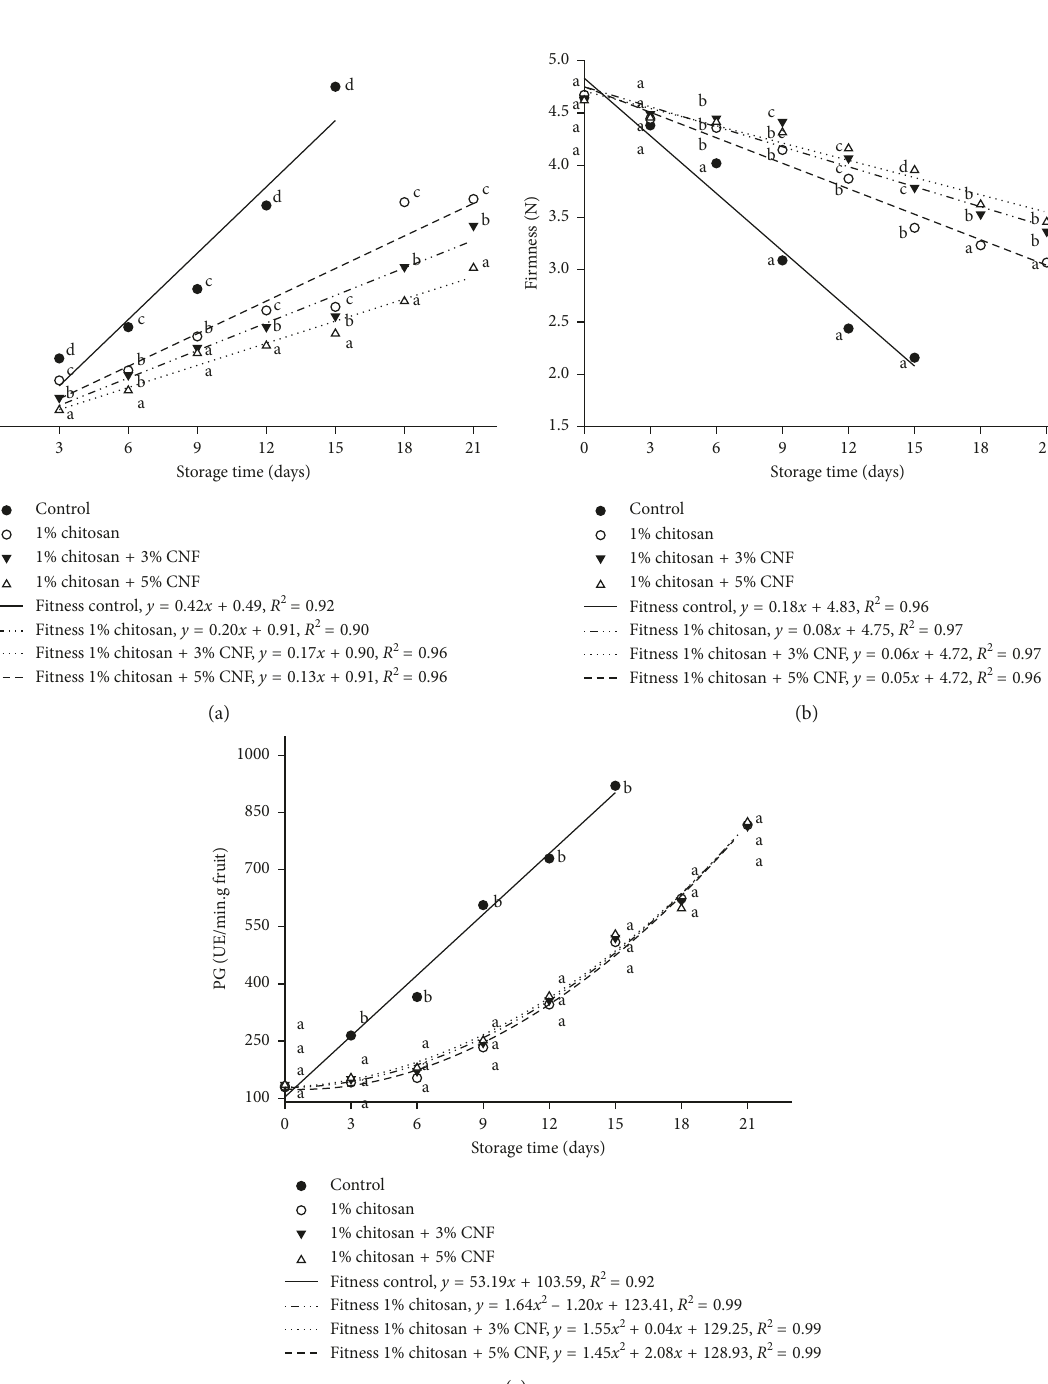
Figure 2: Mass loss, firmness, and polygalacturonase (PG) activity in strawberries stored for 21 days at 1 ° C with and without coating. Same letters in the same storage time denote that averages do not differ by the Tukey test at 5%